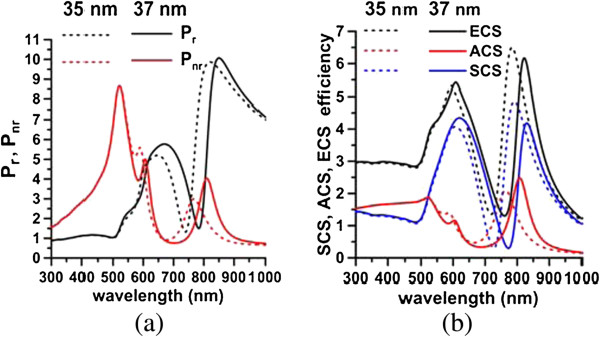
Radiative and nonradiative powers (a) and SCS and ACS of nanomatryushka (b). [a1, a2, a3] = [75, 50, 35] nm and [a1, a2, a3] = [75, 50, 37] nm (d = 25 nm). ECS = SCS + ACS.